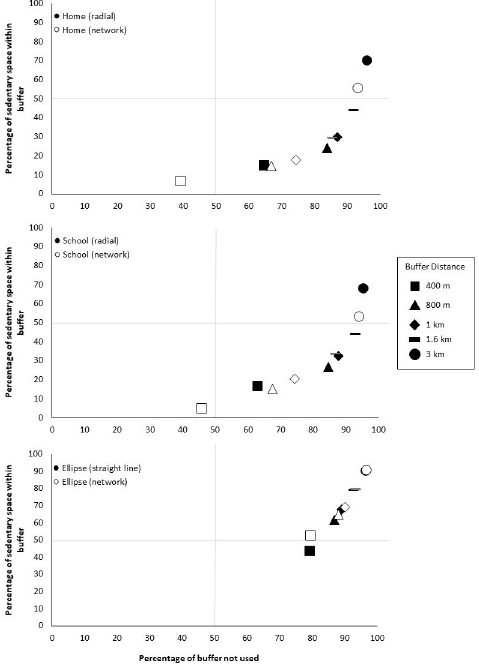
Fig 3. Comparison of buffers in capturing sedentary space and unused space by home, school and ellipse.